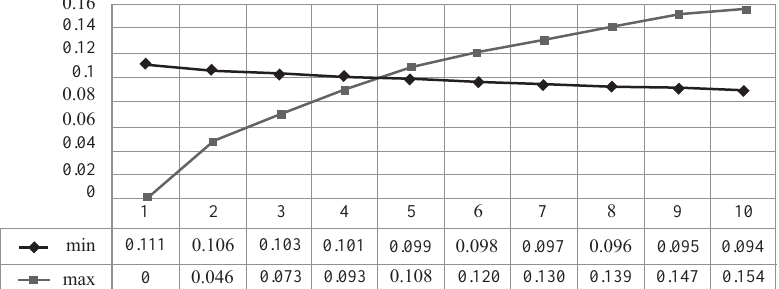
Fig. 4. Example according to formula